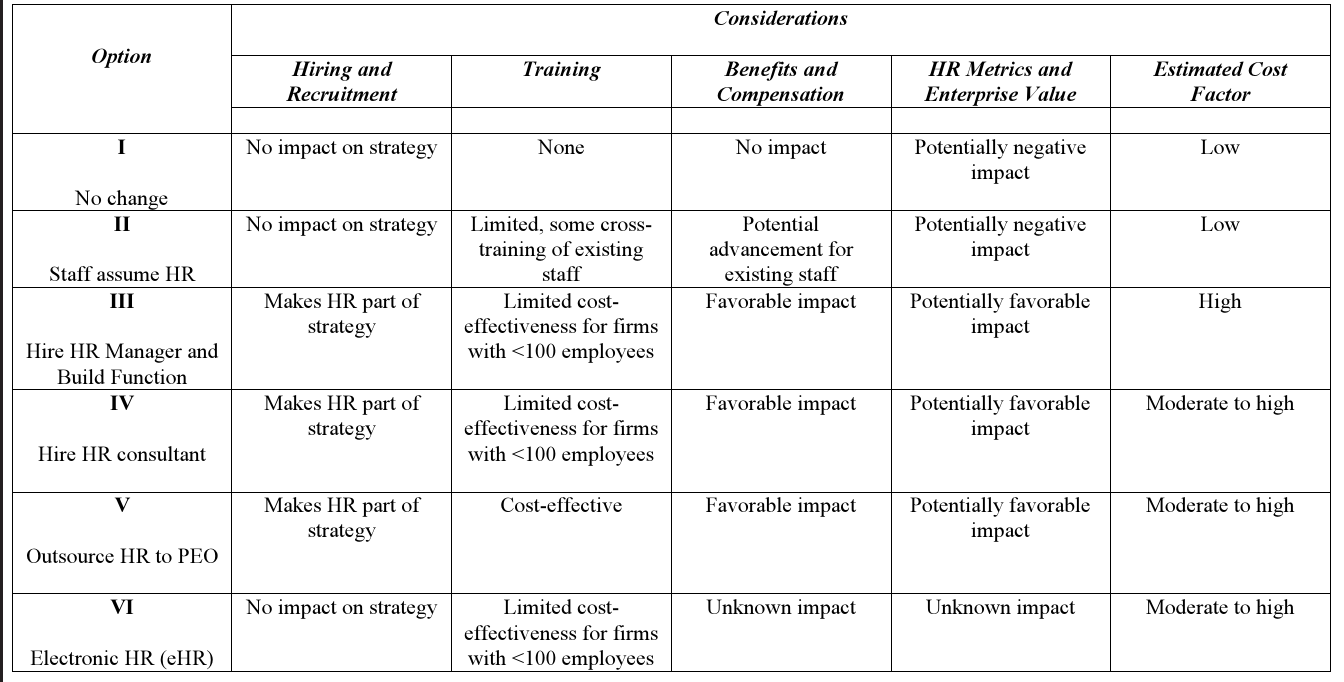
Table 2. HR Decision-Making Matrix for Small and Medium-Sized